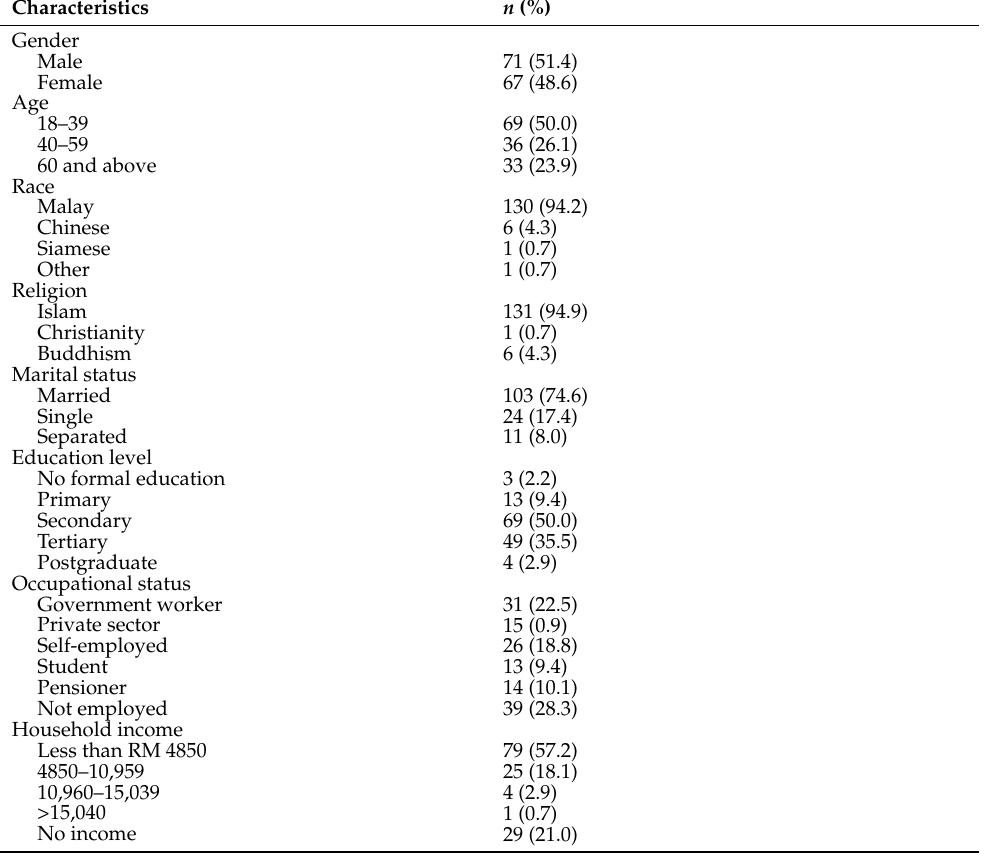
Table 1. Sociodemographic characteristics of the patients ( n = 138).